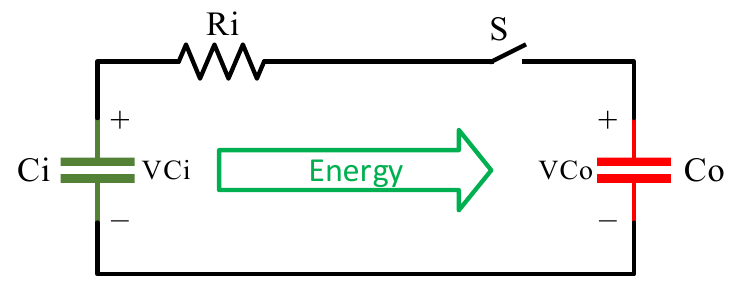
Figure 21. Circuit representing the energy transfer between two capacitors.